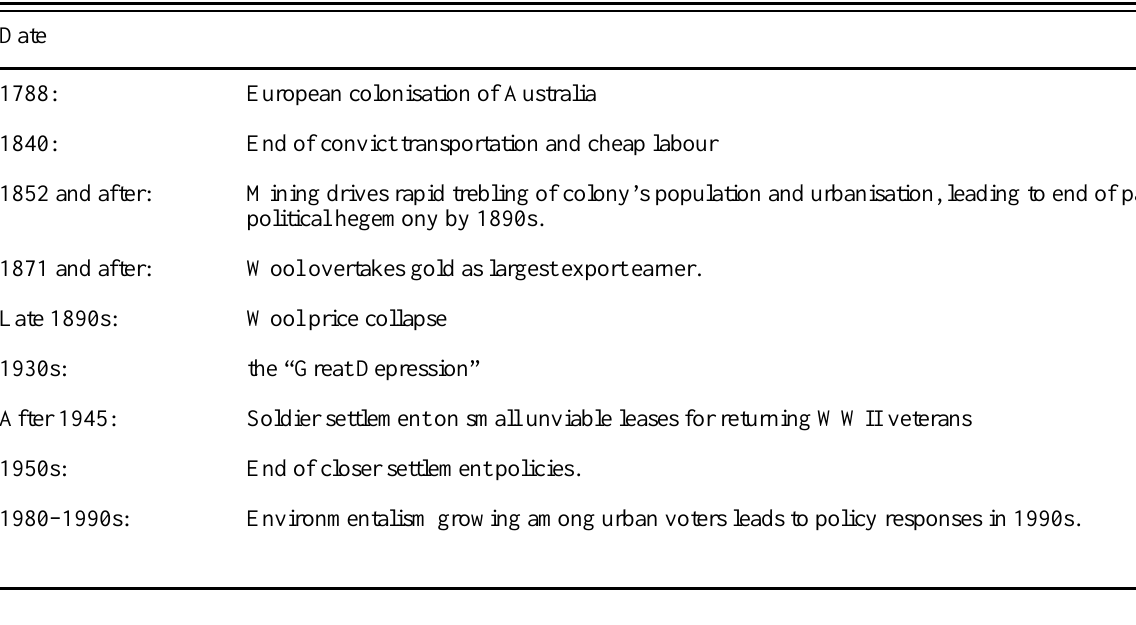
Table 1. Key dates in government-pastoral